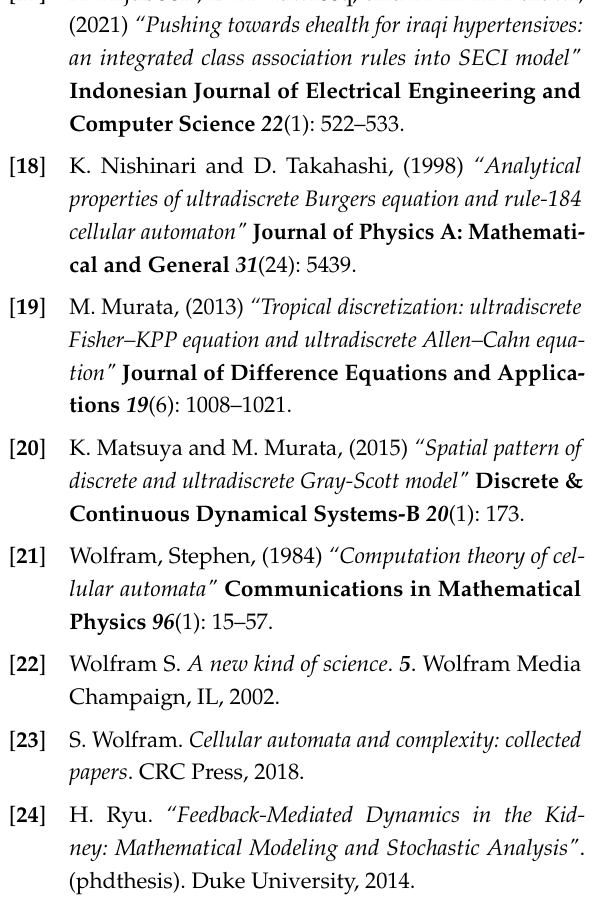
Fig. 5. Pressure perturbations in coupled nephron